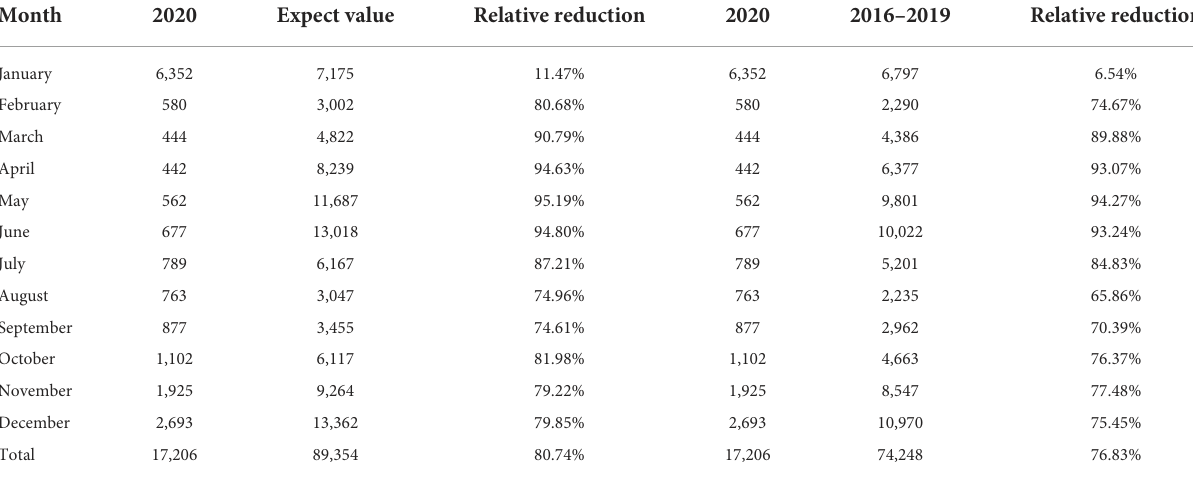
TABLE 3 Comparison between actual and expected incidence in 2020, and the relative reduction in average incidence from 2016 to